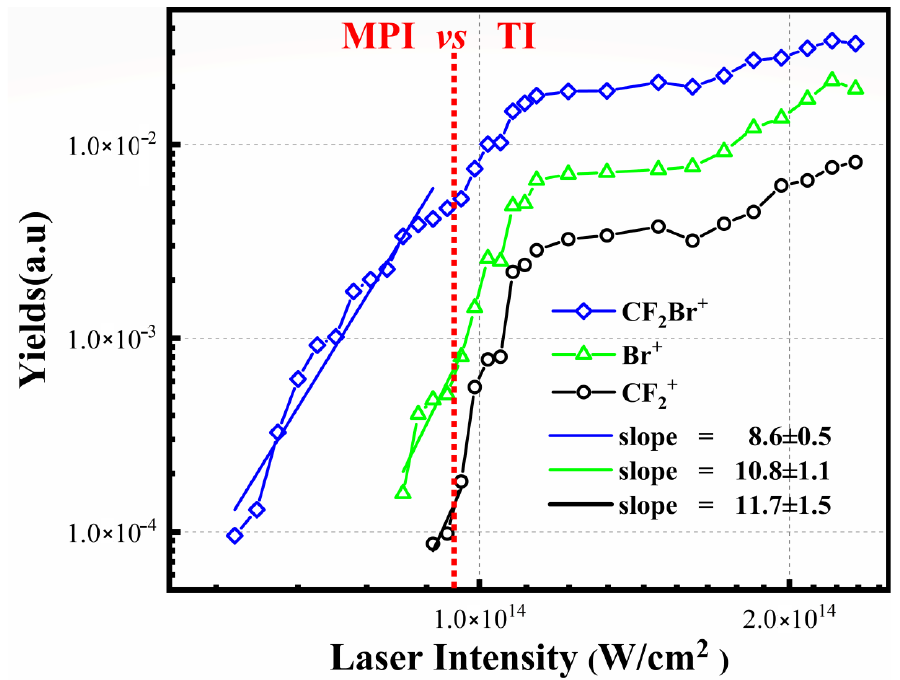
Figure 3. The schematic diagram of the ion yields as a function of the laser intensity in logarithmic coordinates, the red dashed line represents the critical intensity for multi-photon ionization (MPI) and tunnel ionization